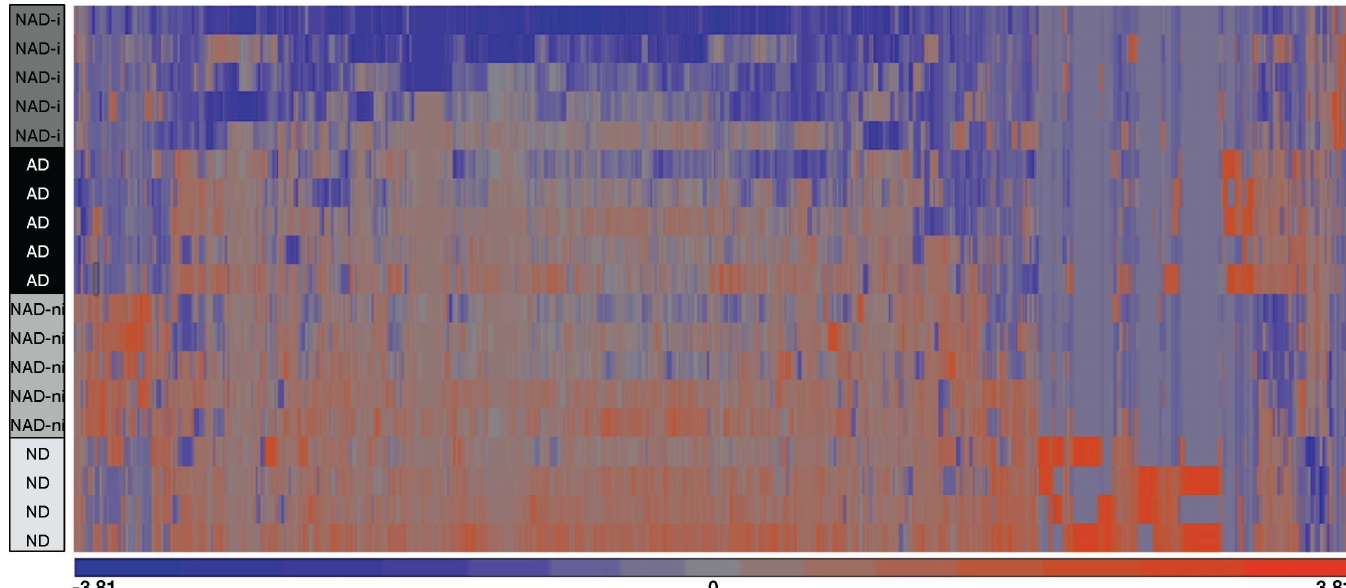
Fig 2. Differential protein expression. Several proteins are differentially expressed in the EDM tissues of patients with different severities of diabetes mellitus. Unbiased clustering of proteins differentially expressed in the four different severities of disease used in this study. Proteins represented in this cluster analysis were determined by ANOVA, P < 0.05. Orange indicates protein upregulation, purple/blue indicates downregulation, and gray represents no expression.